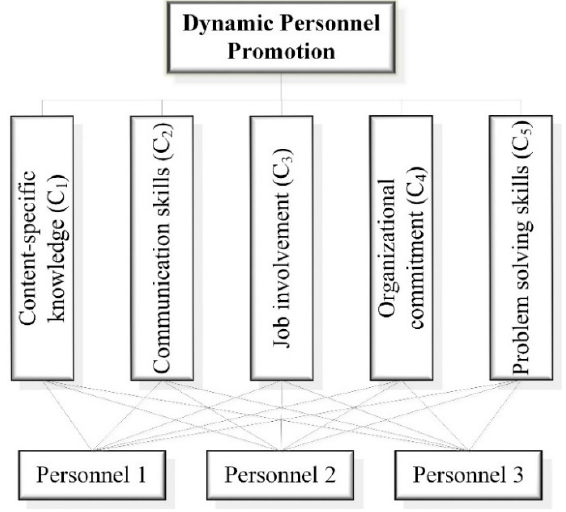
Figure 5. Decision hierarchy.